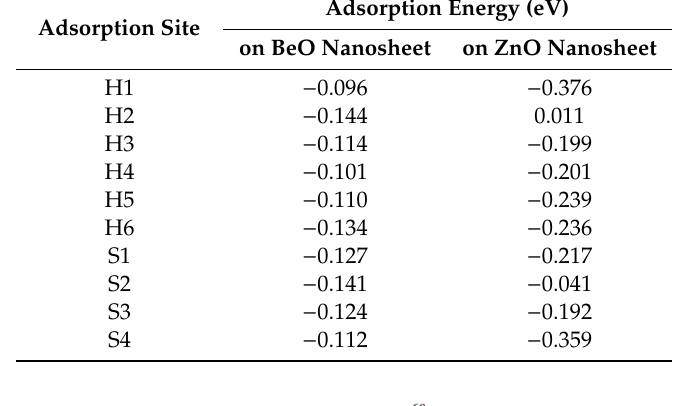
Table 1. Calculated adsorption energies of H 2 S on ZnO and BeO nanosheets at the di ff erent adsorption sites shown in Figure 2.